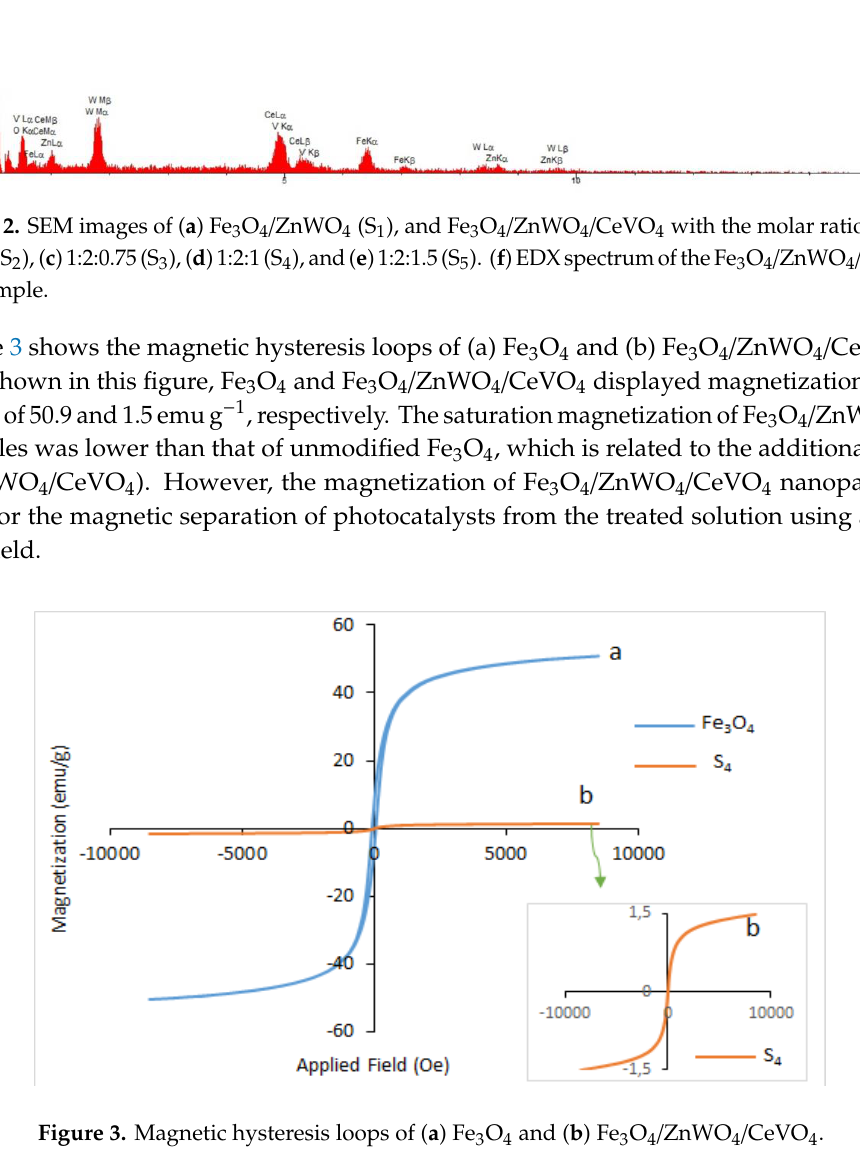
Figure 4. Tauc’s plot of the S 1 and S 4 samples. Fourier transform infrared spectroscopy (FTIR) was performed to assess the chemical structure of Fe 3 O 4 , Fe 3 O 4 /ZnWO 4 (S 1 ), Fe 3 O 4 /ZnWO 4 /CeVO 4 (S 4 ) (before and after calcination), and S 4 after the